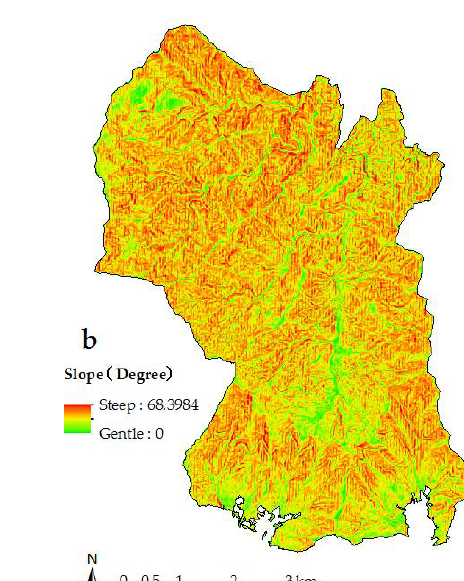
Figure 7. Elevation ( a ) and inclination ( b ) in the study area.